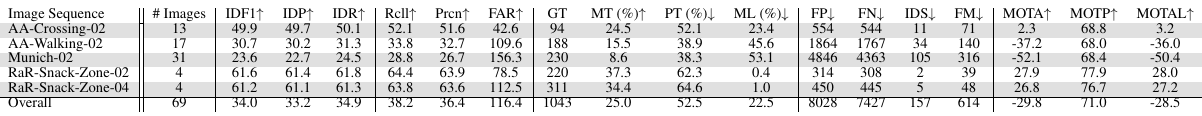
Table 5. Quantitative results of the GOT-NF-3Conv/150 model on different image sequences of the Person dataset. ↑ and ↓ stand for “higher and lower is better” accordingly.